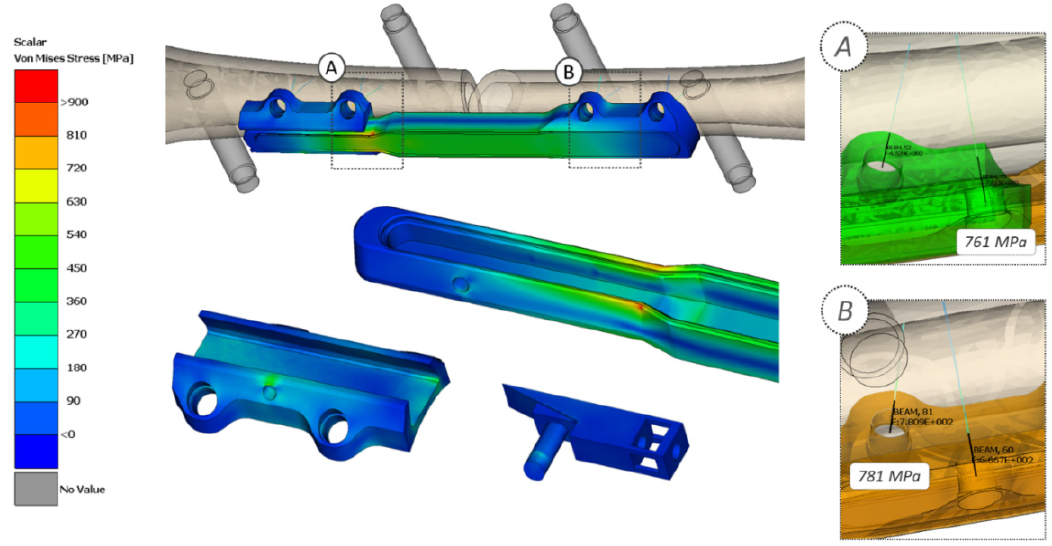
Figure 9. Maximum von Mises stress at the experimental peak static load (2 kN): detail of plate components and more stressed screws ( A and B boxes).